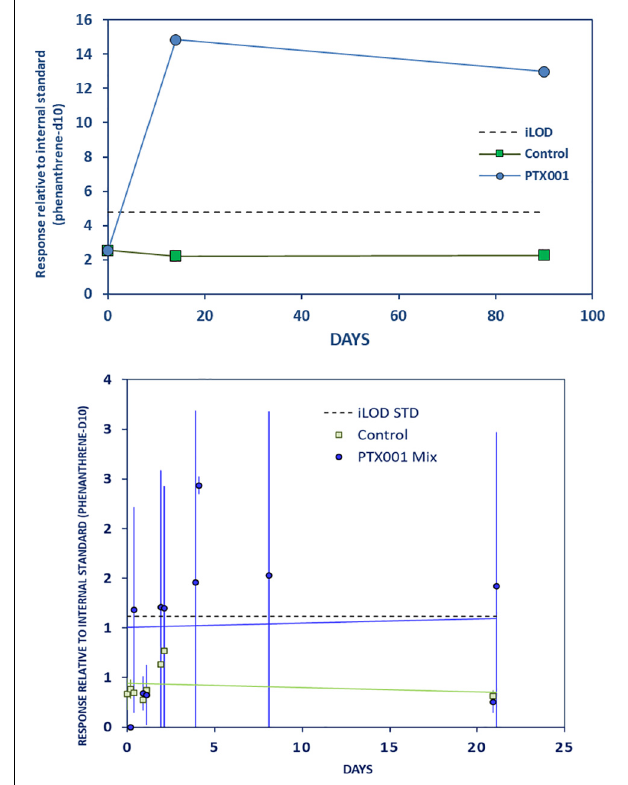
FIGURE 5 | Strong initial leaching of TCEP from PTX001 to stomach oil. Left: long-term experiment. Further caption details as in Figure 2